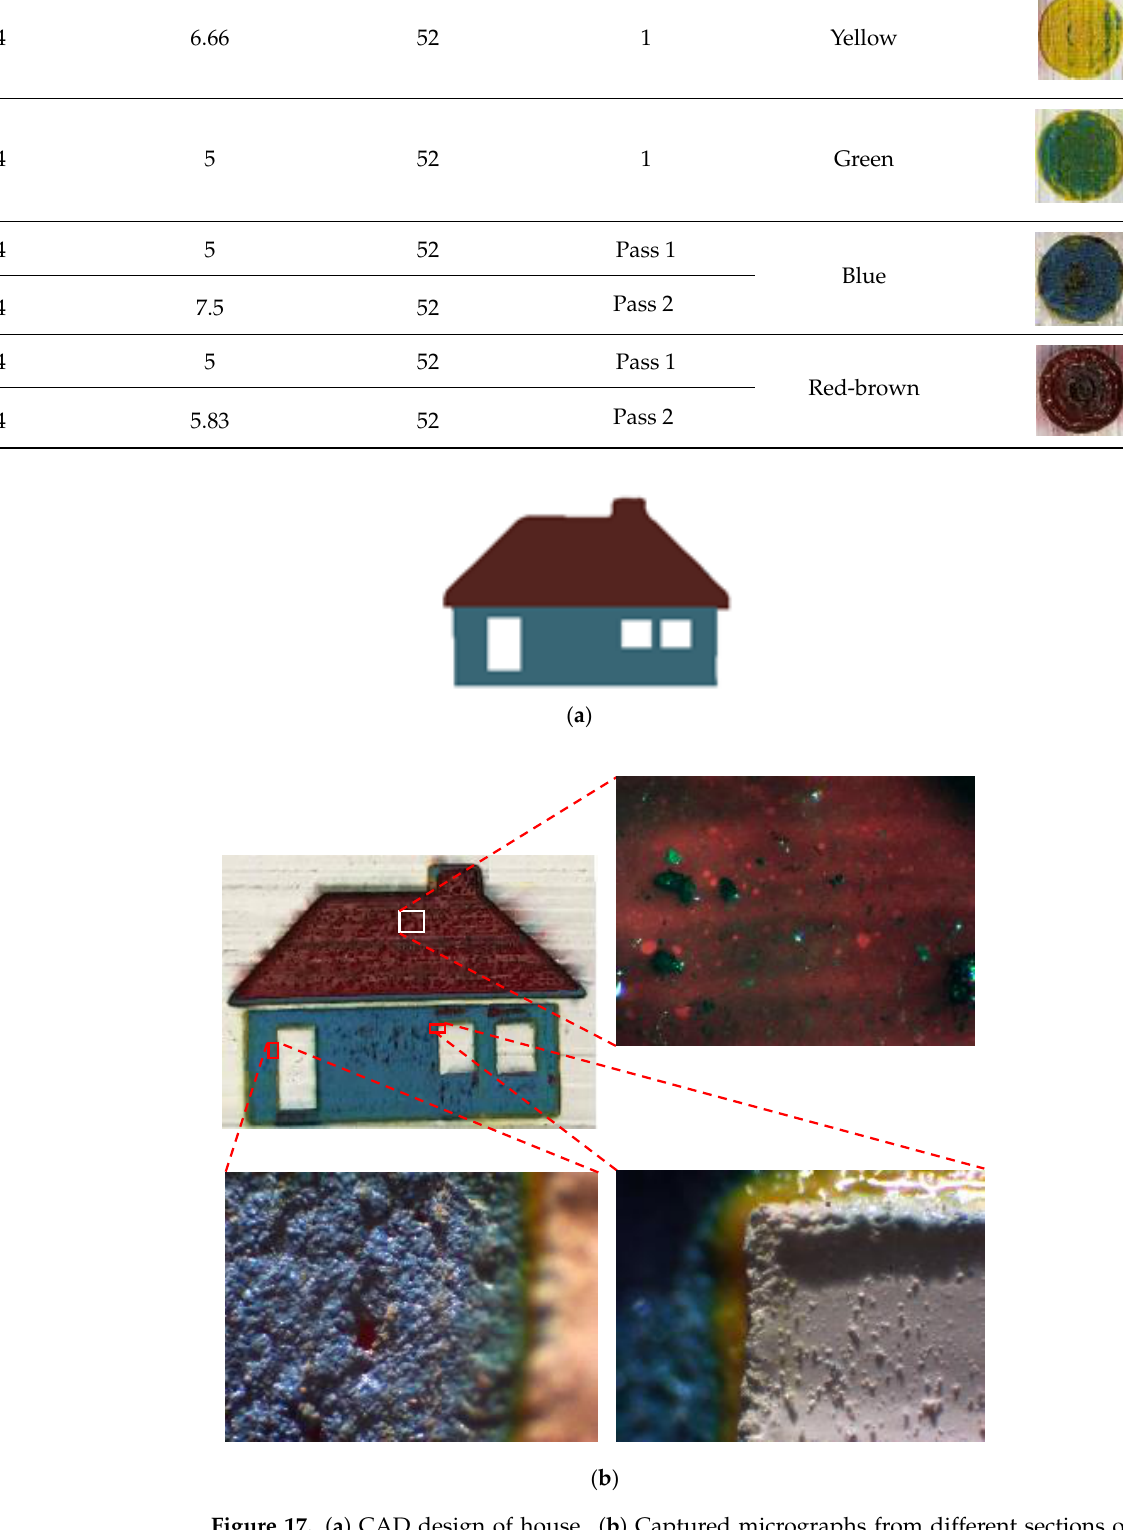
Figure 17. ( a ) CAD design of house. ( b ) Captured micrographs from different sections of laser-decolorized house.